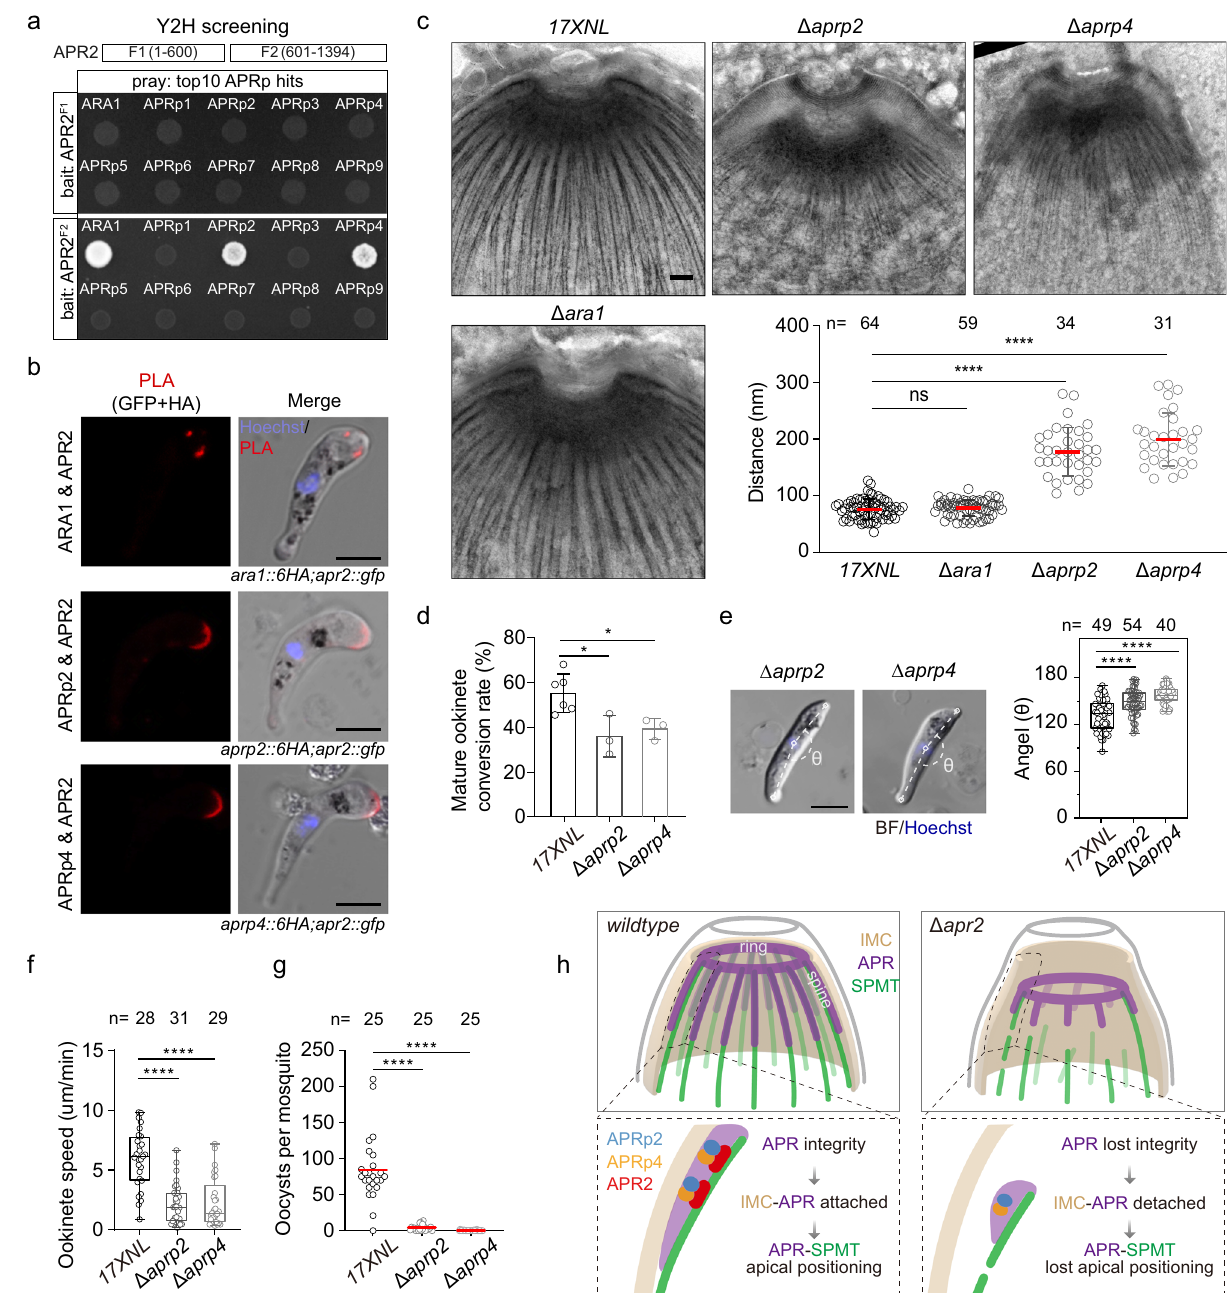
Fig. 9 | APR2-APRp2-APRp4 module regulates apical anchorage of APR-SPMT. a Yeast two-hybrid (Y2H)assayforscreening the APR2 directly interacting protein. UsingtwofragmentsF1(1 – 600,aa)andF2(601 – 1394,aa)ofAPR2asthebait.Yeast expressingpairedbait-prayconstructsweregrownundertherestrictiveconditions to detect their interactions. Representative results from two independent experi- ments. b PLA detecting protein interaction between APR2 and ARA1, APRp2 and APRp4 in ara1::6HA;apr2::gfp , aprp2::6HA;apr2::gfp and aprp4::6HA;apr2::gfp ooki- netes. Scale bars: 5 μ m. Two independently performed experiments with similar results. c Representative images from negative staining TEM (NS-TEM) of 17XNL , Δ ara1 , Δ aprp2 , and Δ aprp4 ookinetes. More images are shown in Supplementary Fig.8A.Scalebars:200nm.Quanti fi cationofdistancebetweenSPMTandtheapical membrane-likelayerwasshowninlowerrightpanel. n isthenumberofookinetesin eachgroupfromthreeindependentexperiments.Valuesaremeans±SD.Fromleft to right: ns P =0.43, **** P =2e-29, and **** P =6e-33, by two-sided Mann – Whitney test. d Mature ookinete conversion rate. Values are means±SEM ( n =3 biological